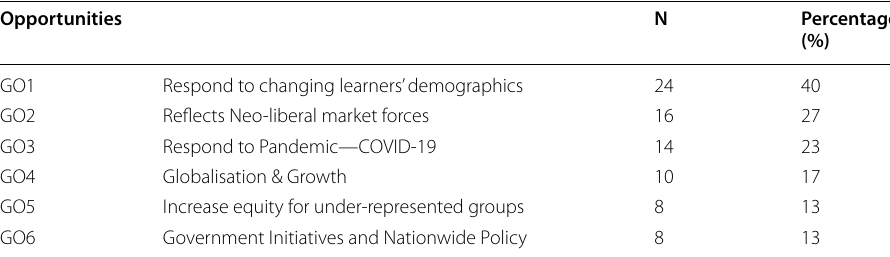
Table 7 Summary view of the opportunities and critical challenges offered by micro-credentials for government